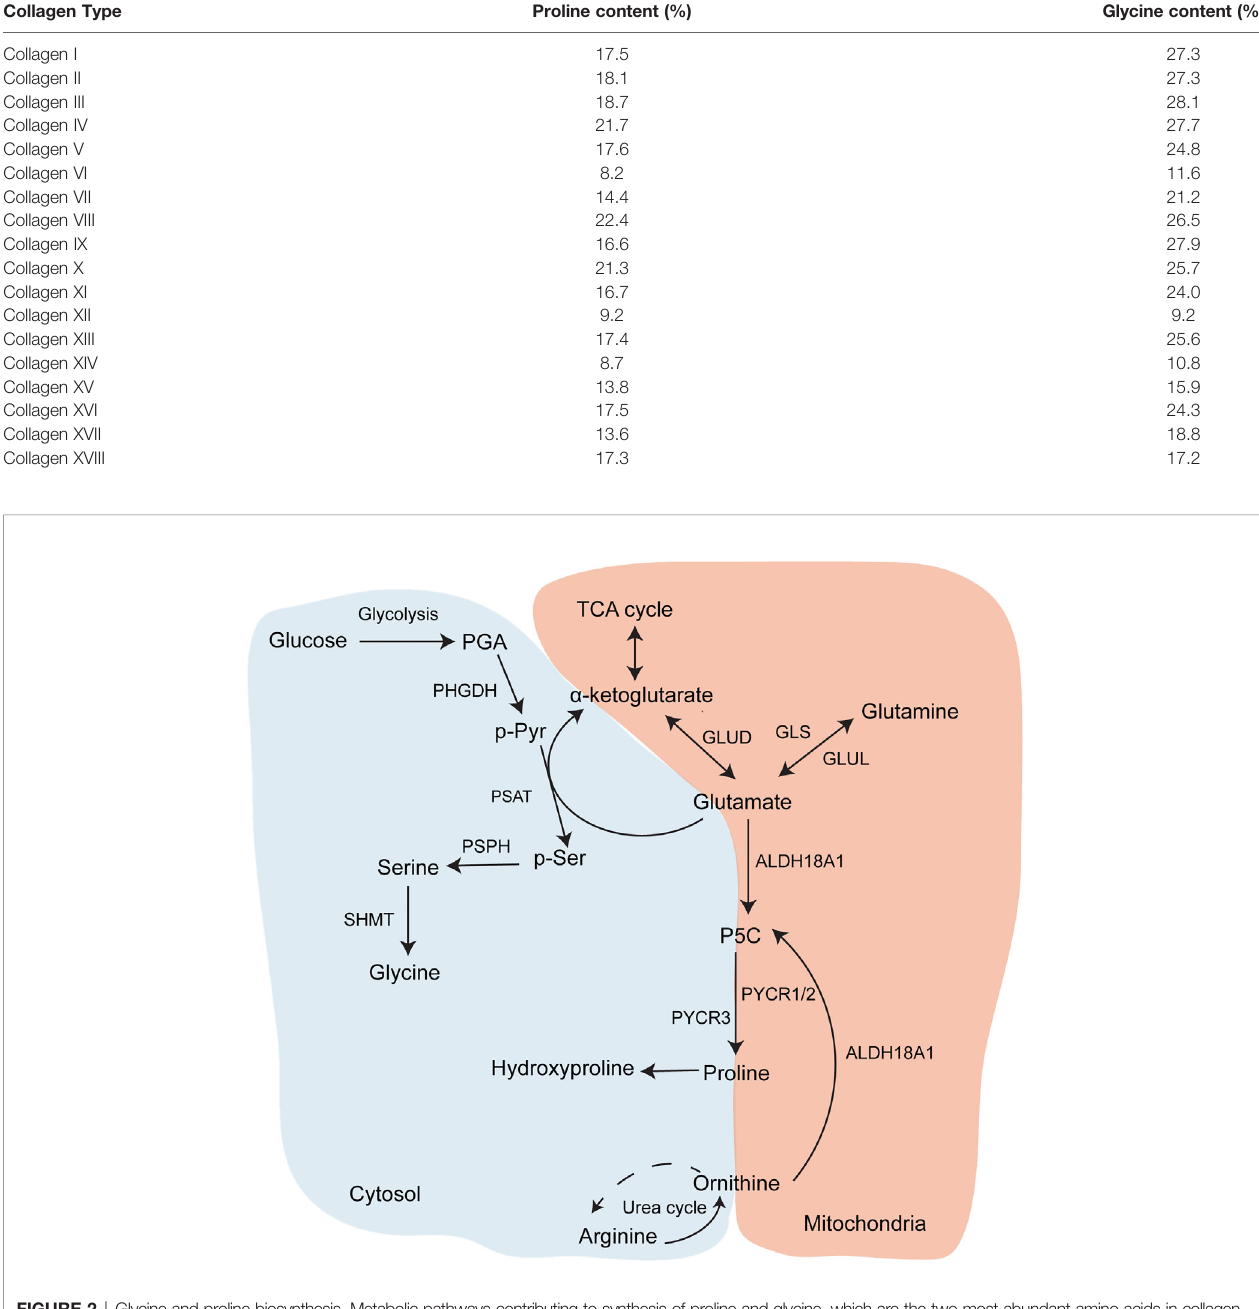
FIGURE 2 | Glycine and proline biosynthesis. Metabolic pathways contributing to synthesis of proline and glycine, which are the two most abundant amino acids in collagen.